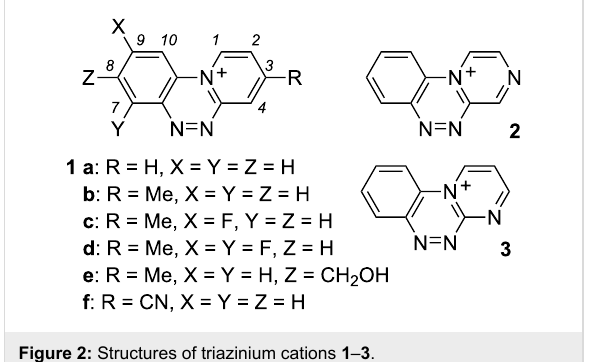
Figure 2: Structures of triazinium cations 1 – 3 .